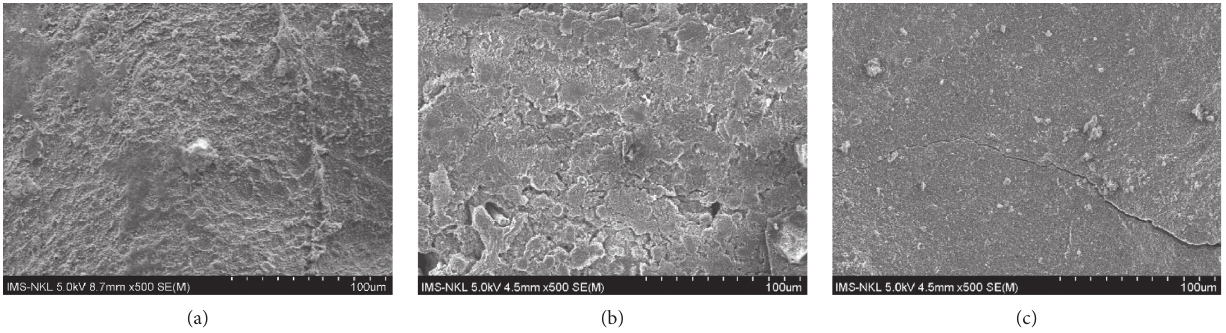
Figure 10: SEM images of the electrode-coated CI-IPA (1/1) (a), CI-IPA (1/0.5) (b), and CI-IPA (1/2) ink